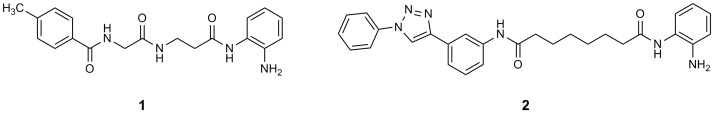
Previously reported HDAC3-selective inhibitors 1 and 2.